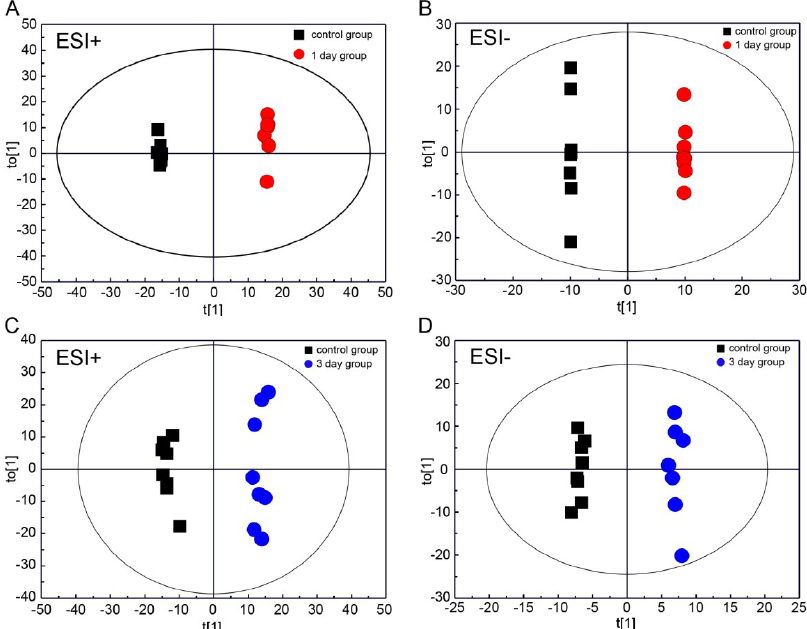
Figure 2. Score plots from OPLS-DA analysis ( n = 8). ( A – B ) control group and 1 day group; ( C – D )